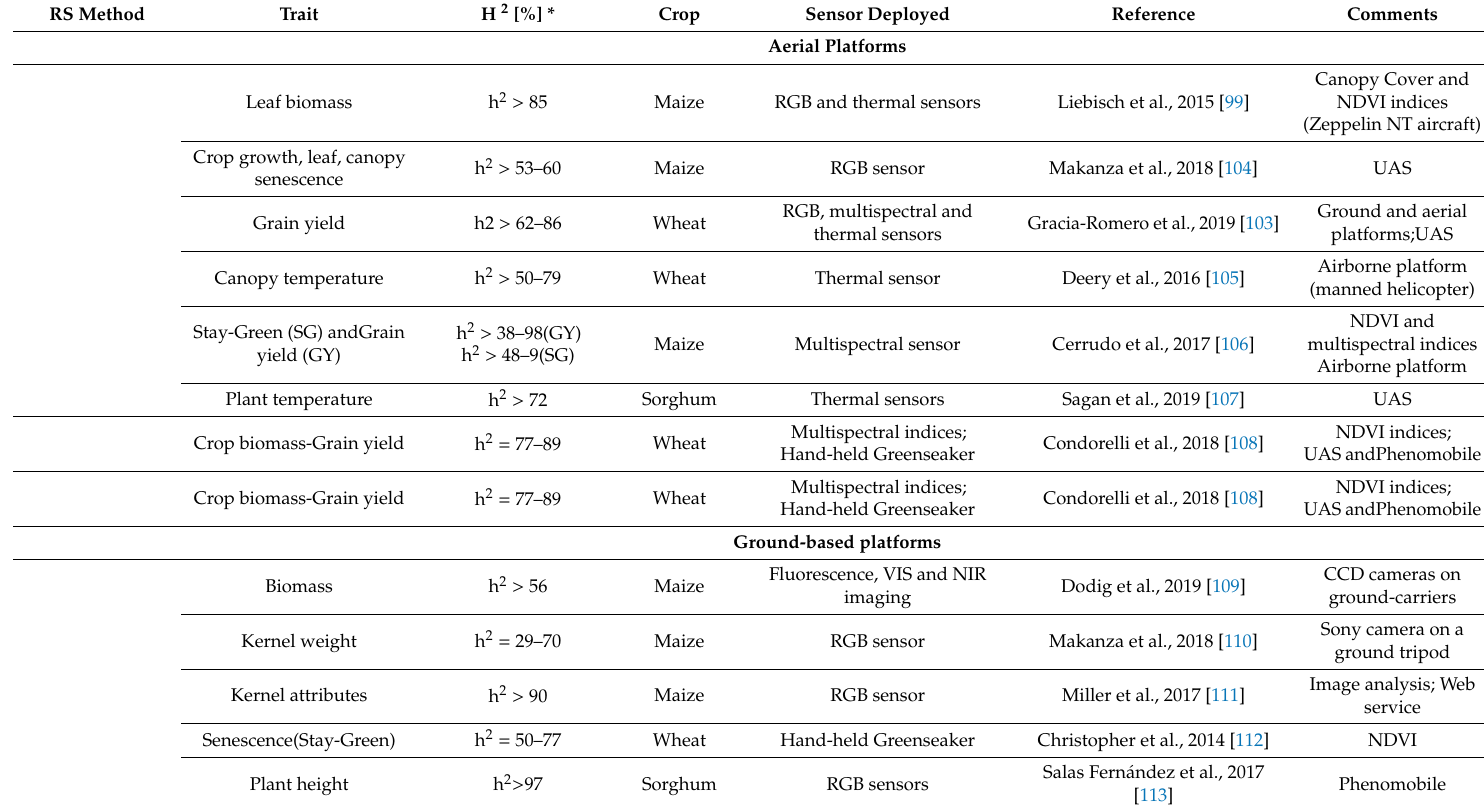
Table 3. Heritability measured with currently used remote sensing (RS) methods: ground-based, aerial platforms and sensor deployed across senescence and biomass related